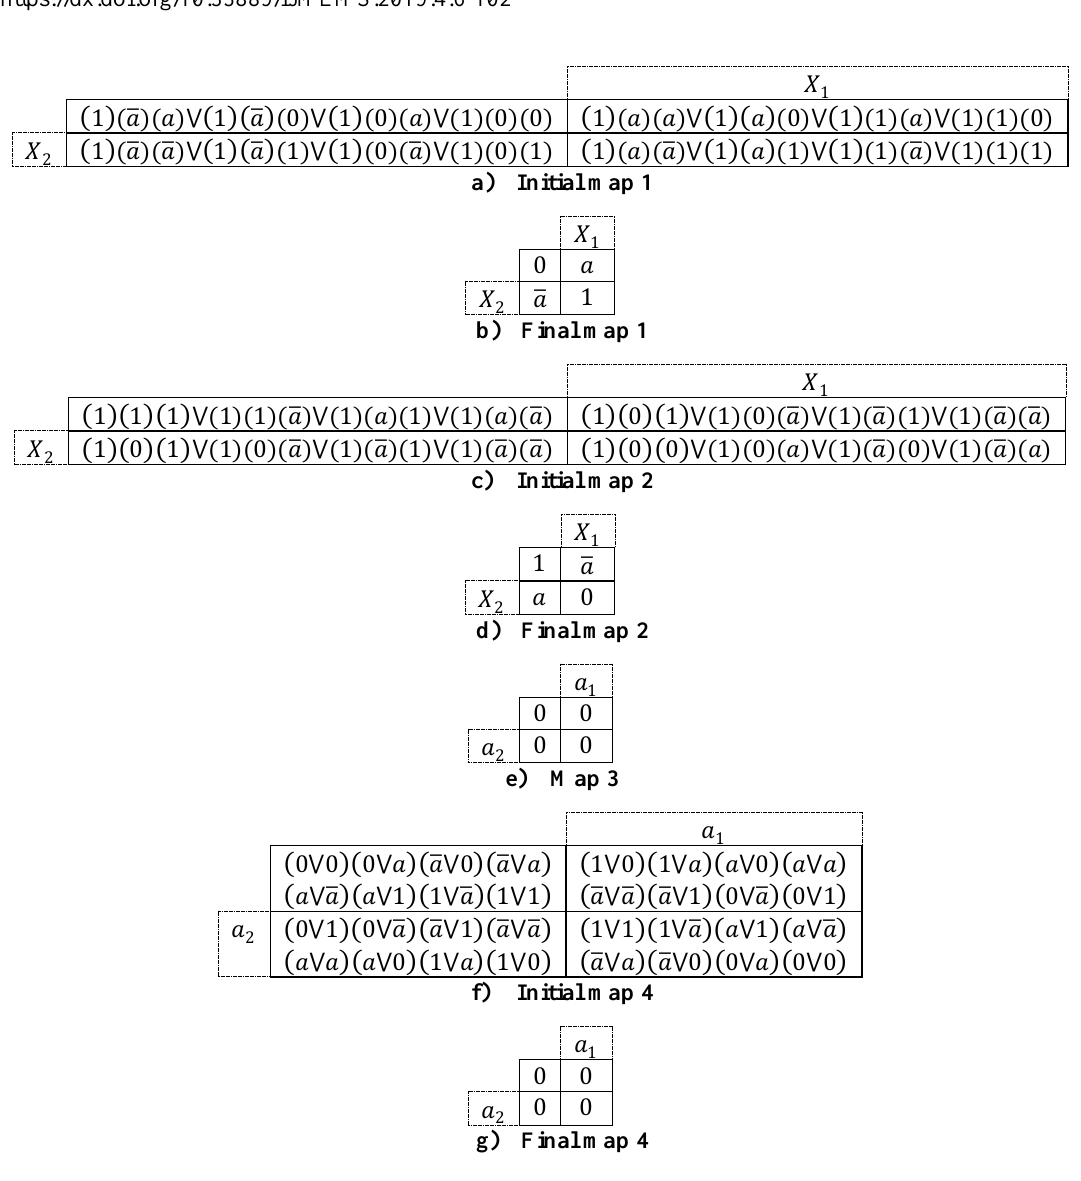
Figure 2. VEKMs for example